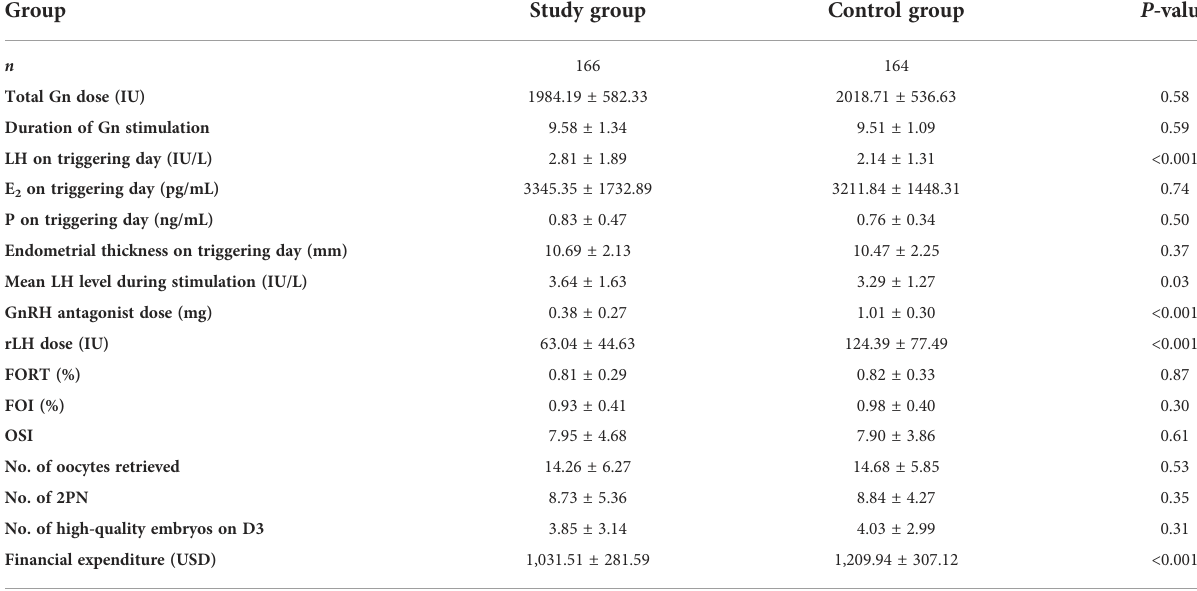
TABLE 2 The per-protocol population ovarian stimulation and laboratory outcomes. Group Study